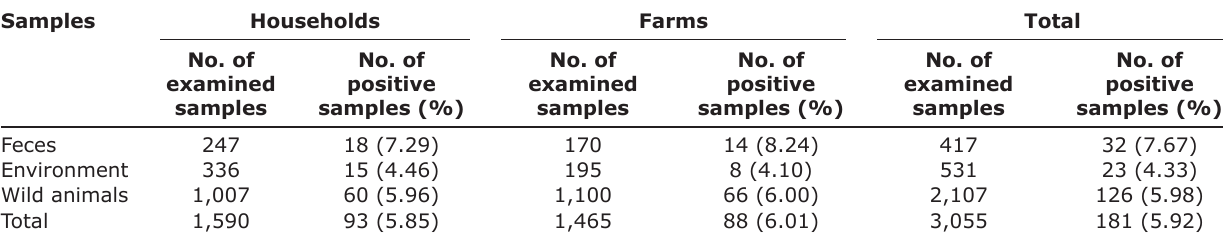
Table-2: Prevalence of Salmonella in the environmental samples in the poultry farms and households. Samples Drinking water Table-3: Prevalence of Salmonella in wild animals in the poultry farms and households. Species Flies